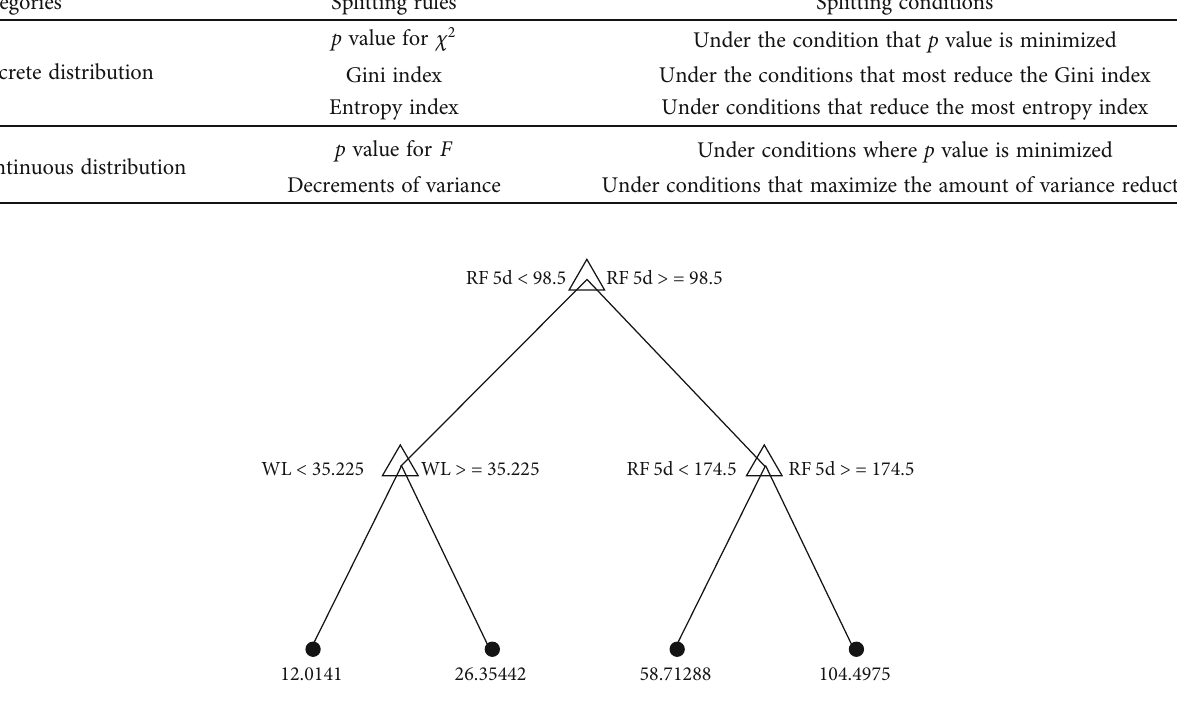
Figure 13: Decision tree for group A (seepage, antecedent 5-day rainfall, and water